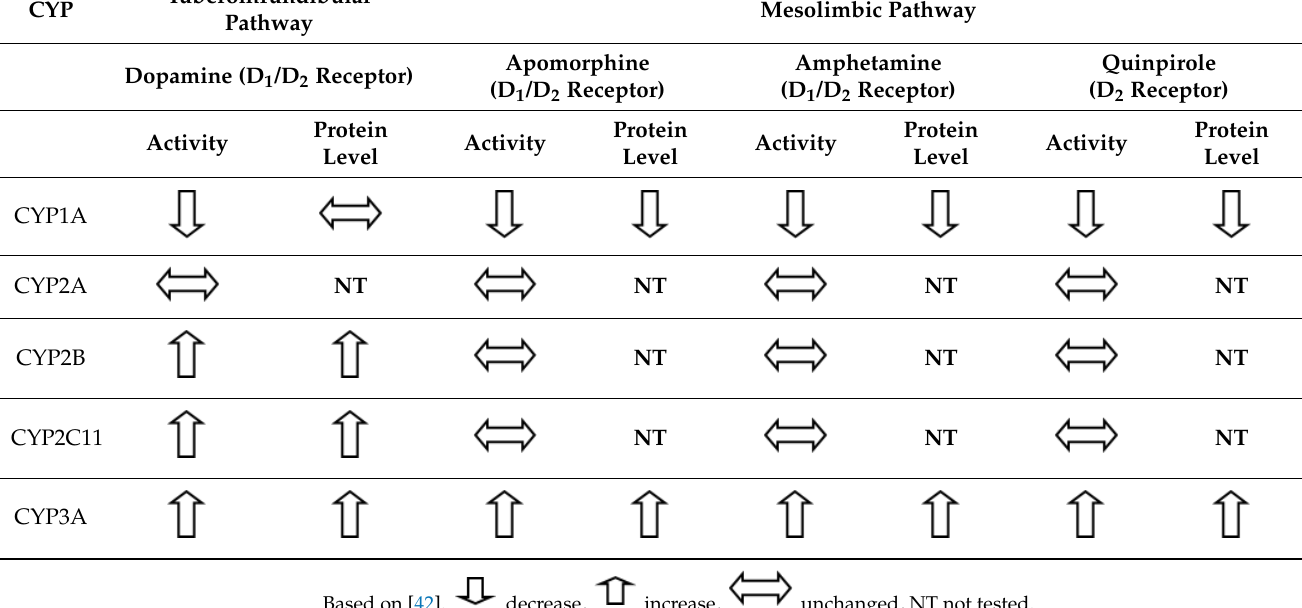
Table 1. Impact of the activation of brain dopaminergic pathways by different ligands of dopamin- ergic receptors on the activity and protein levels of cytochrome P450 (CYP) isoforms in rat liver microsomes.